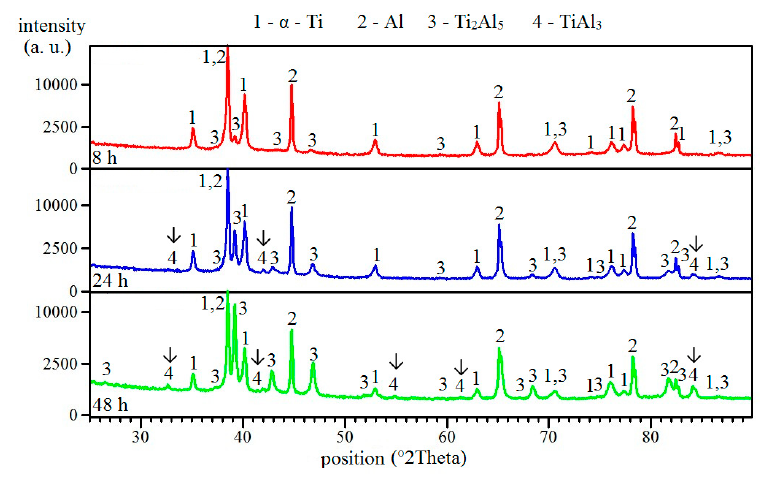
Figure 7. The XRD patterns of TiAl63 alloys annealed at 500 °C for 8, 24, and 48 h.